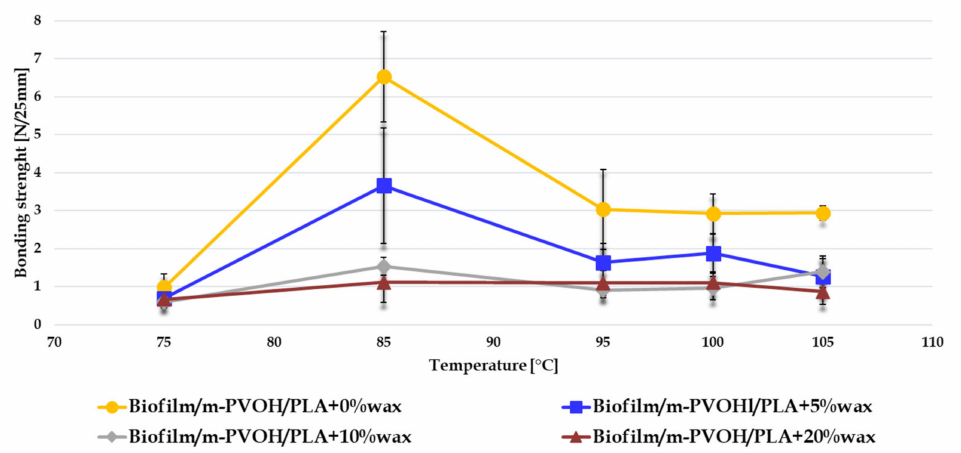
Figure 7. Bonding strength (N/25 mm) of the multilayer